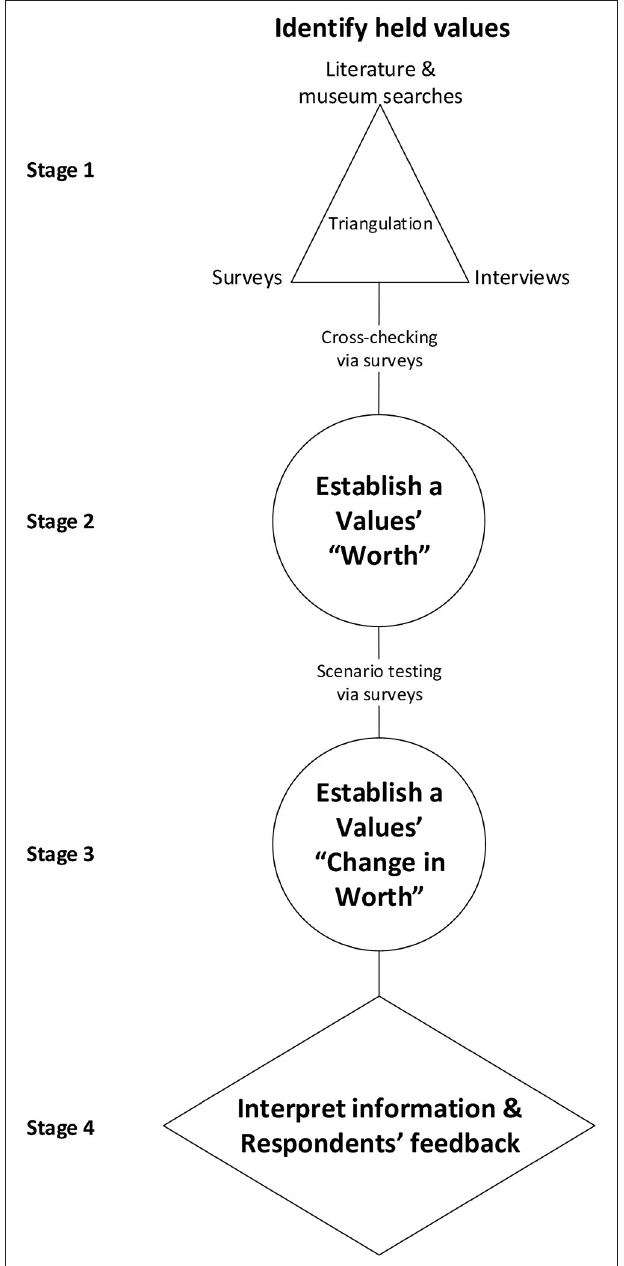
FIGURE 1 | The conceptualized data collection and interpretation